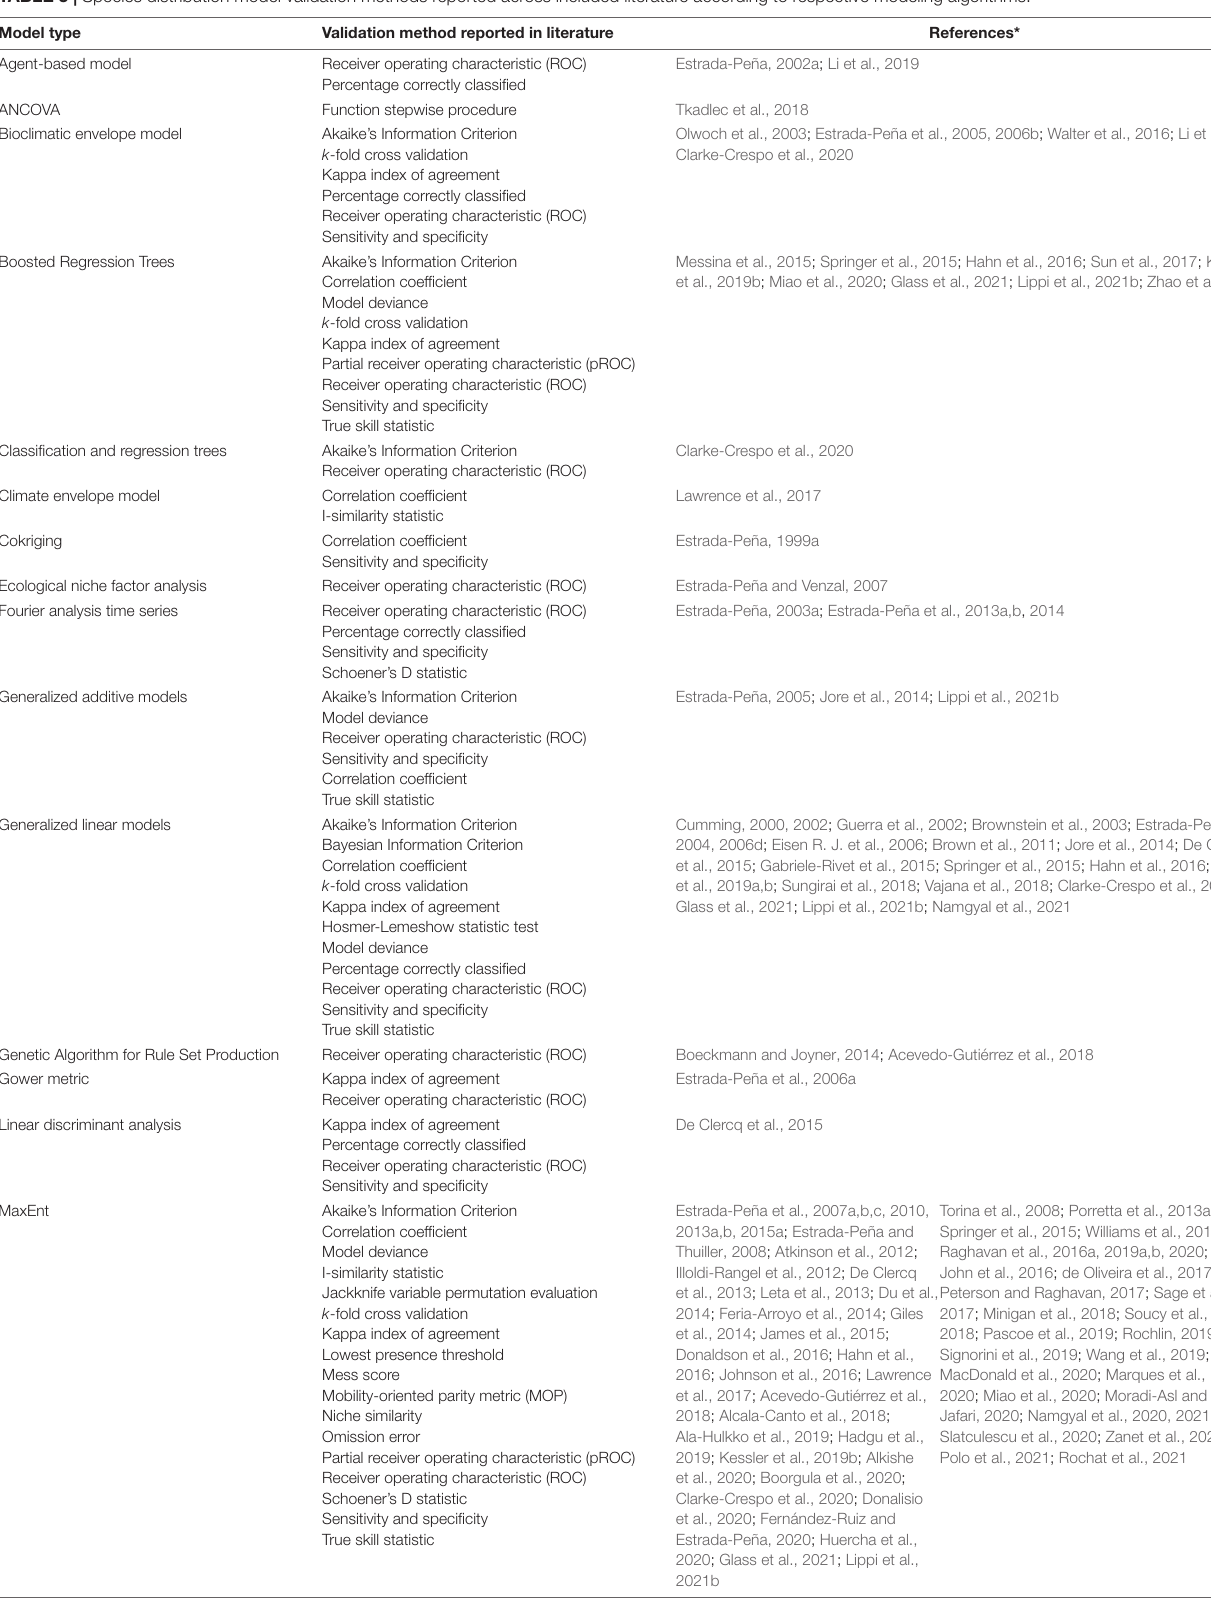
TABLE 3 | Species distribution model validation methods reported across included literature according to respective modeling